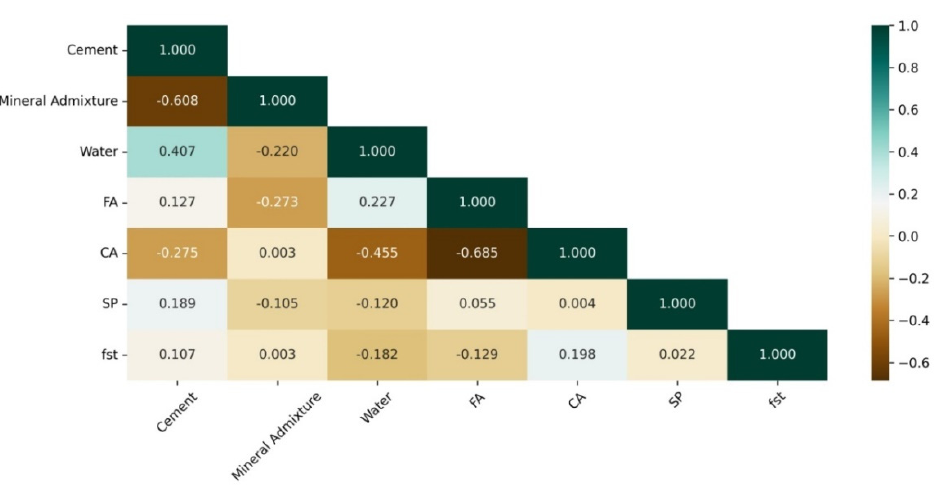
Figure 6. Correlation matrix of the input features.